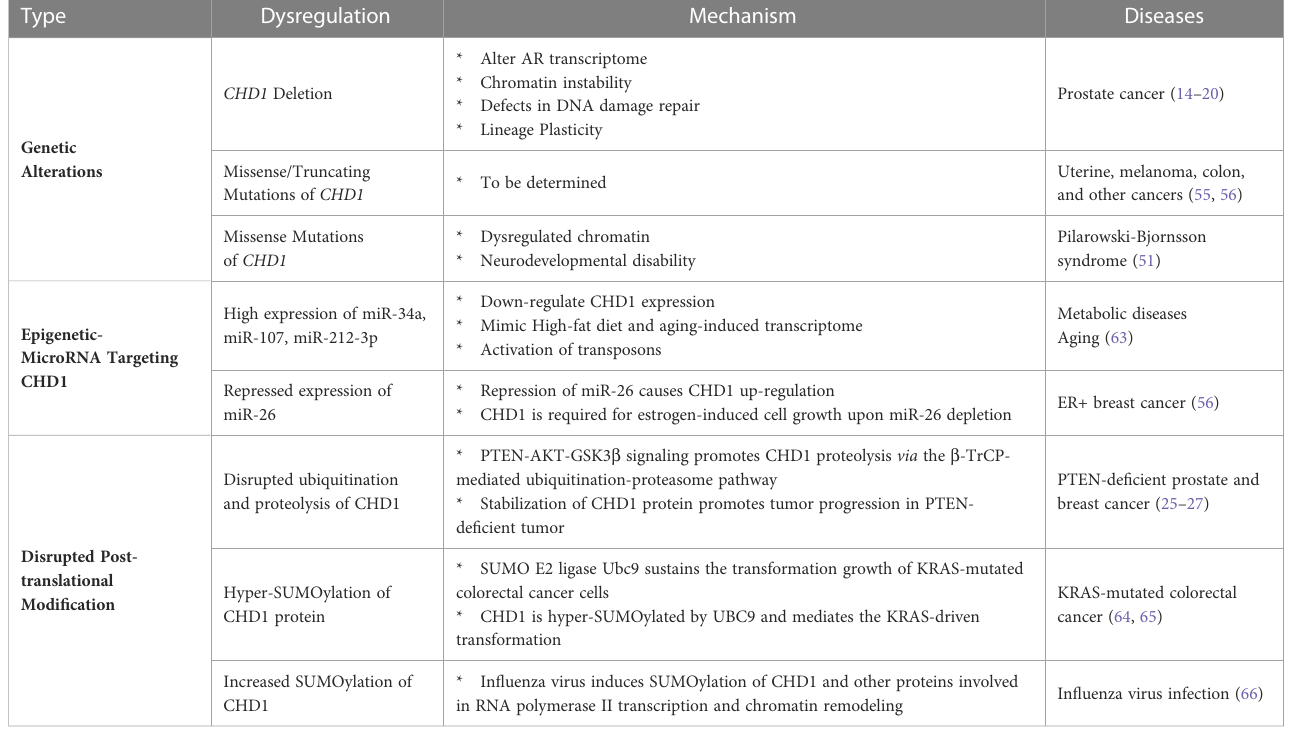
TABLE 1 Dysregulation of CHD1 in human diseases.